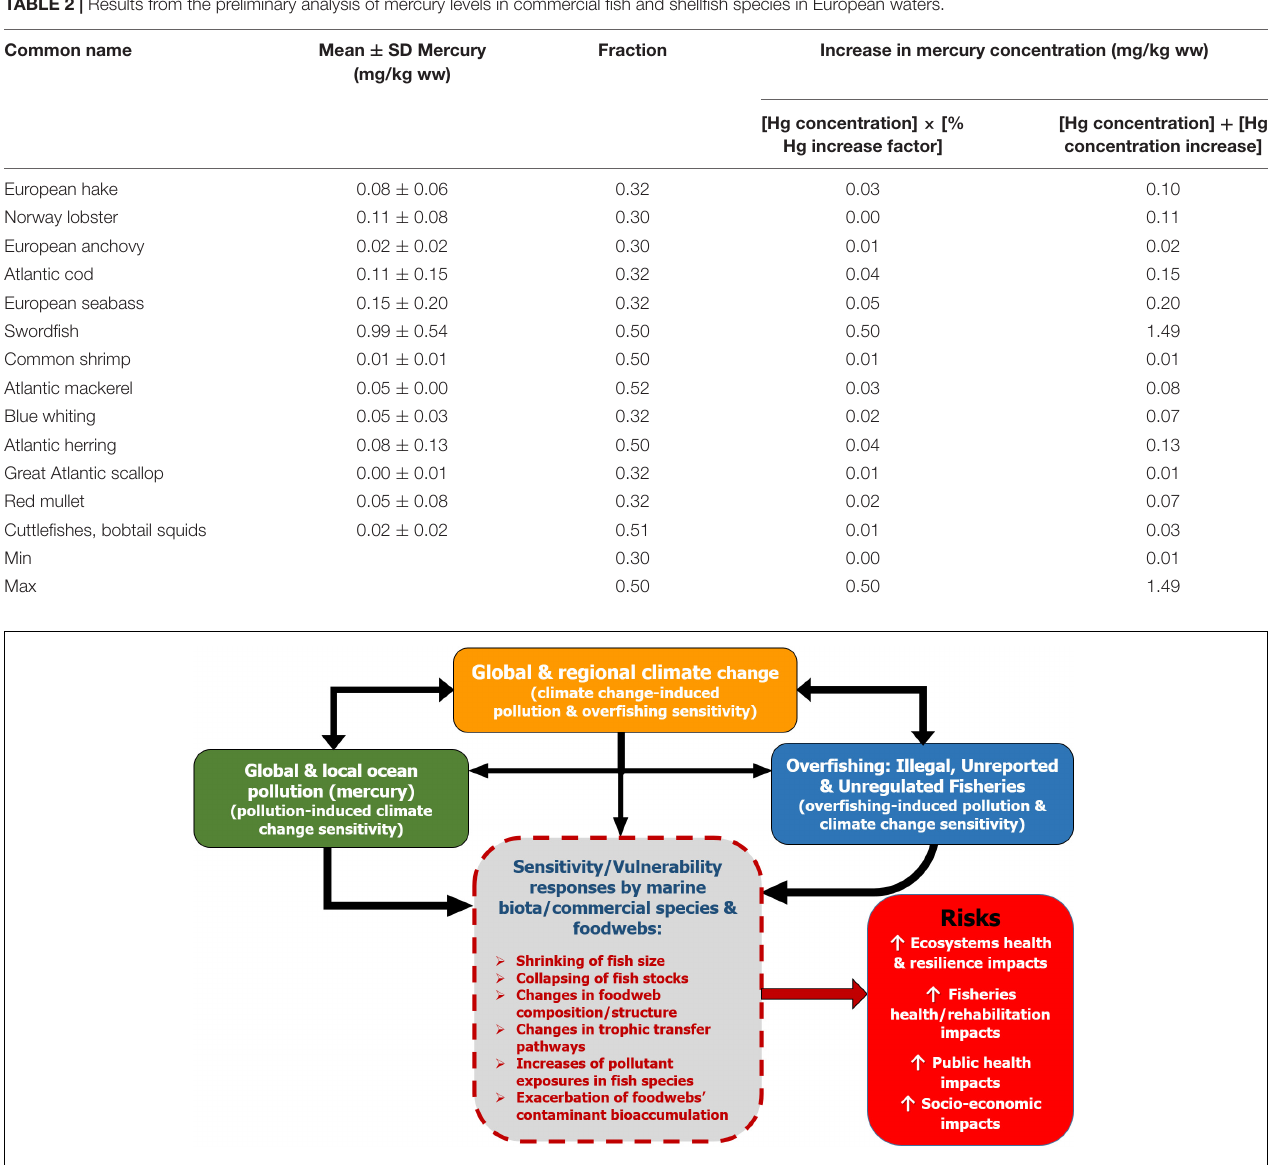
FIGURE 2 | Climate change-overfishing-pollution assessment framework. The pathways through which scenario of climatic, overfishing and pollutants hazards (orange, blue, and green boxes, respectively) and their interactions can lead to increases in exposure to hazards by the biota, ecosystems and people sensitivity (dashed gray box) and the risk of impacts to ecosystem and human health and societies (red box). Climate change is a threat multiplier that compounds overfishing and pollution. For instances, climate change induces fisheries susceptibility and vulnerability to overfishing; while overfishing and climate change influence pollution sensitivity; thus, the resilience of fish stocks and marine ecosystems can be weakened. The synthesis is based on literature review and framework presented in Alava et al. (2017a). Adapted from Alava et al. (2017a) and Bindoff et al.